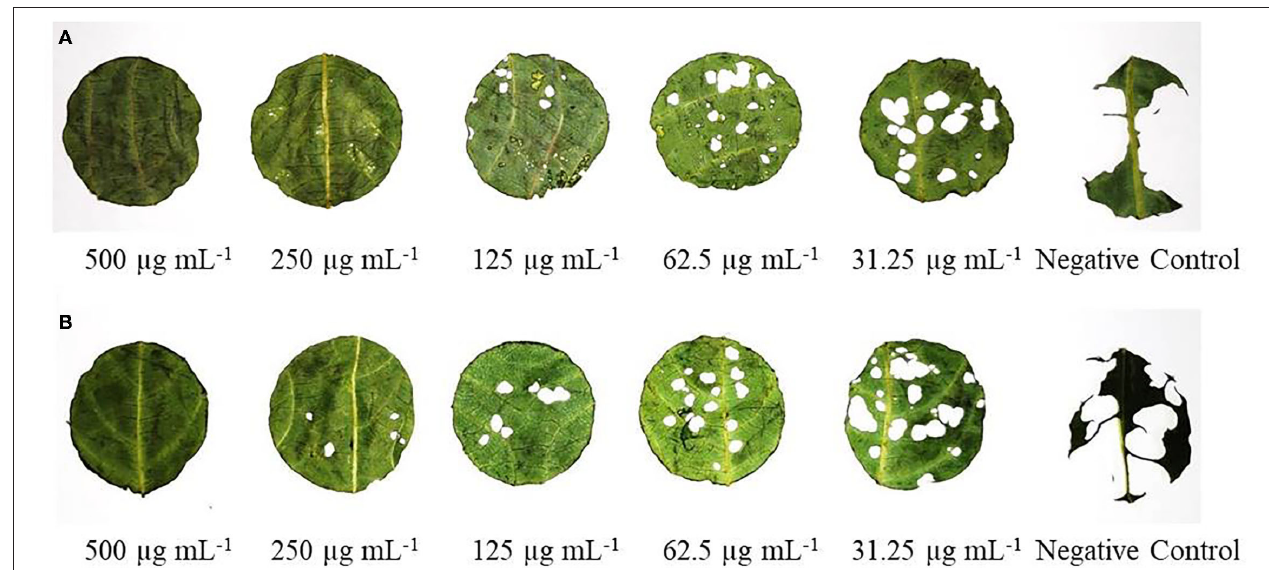
FIGURE 6 | Visual display of antifeedant action of NEs of (A) EO and (B) HE against S. litura third instar larvae after 24h.